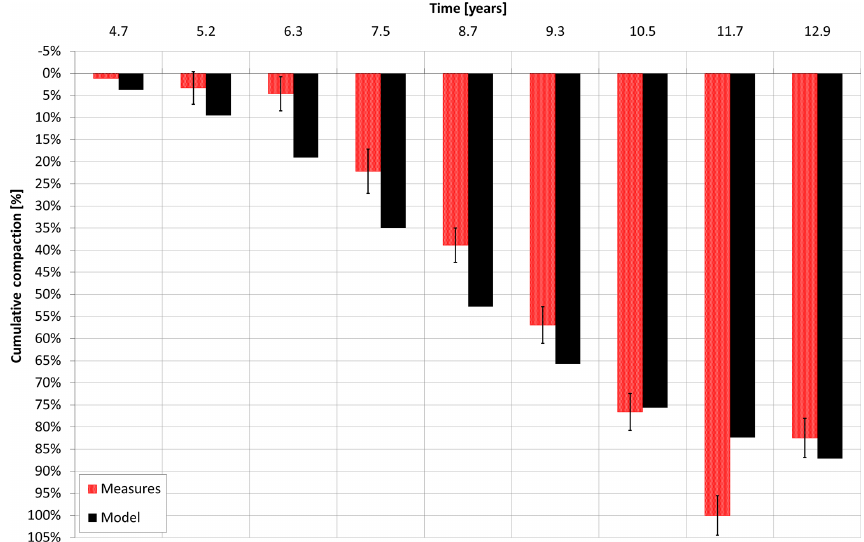
Figure 3. Time evolution of compaction along the monitoring well of platform B: markers data versus model estimates.